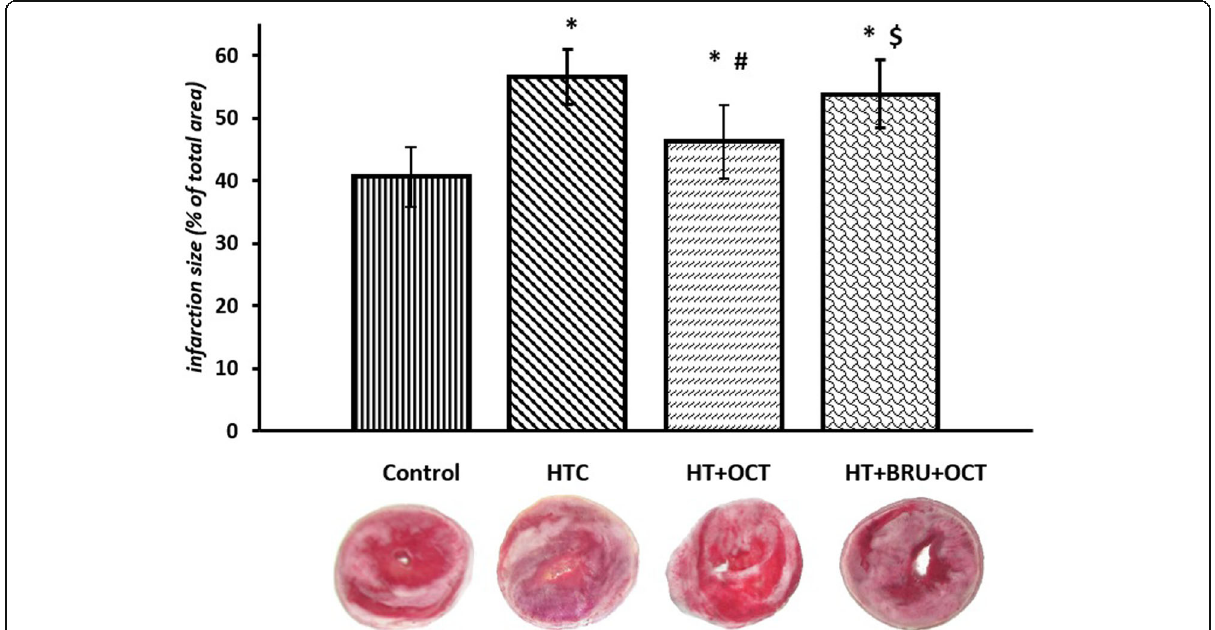
Fig. 2 Effect of octreotide on infarct size (as present of the total area) in rat hearts exposed to ischemia for 30min and reperfusion for 120min. n = 10 rats in each group. Data are represented as mean ± standard deviation. Significance ( P < 0.05): *significant when compared with the control group; # significant when compared with HTC groups; $ significant when compared with HT+OCT